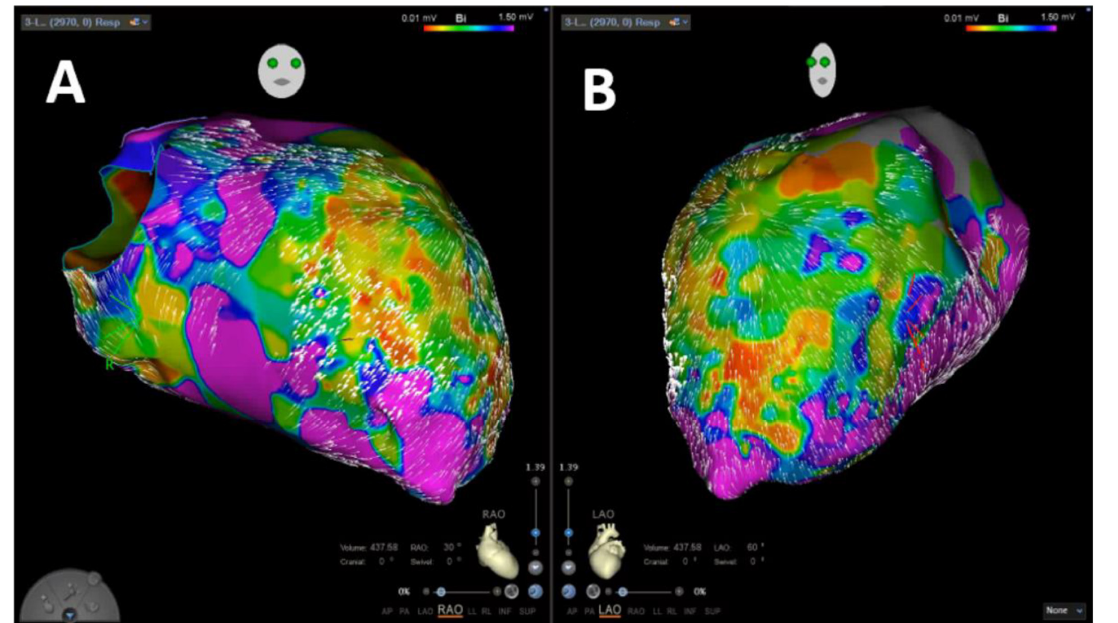
Figure 3. Representative image of left ventricular velocity-vector-based coherent mapping in combination to bipolar voltage mapping in RAO ( A ) and LAO ( B ) projections.